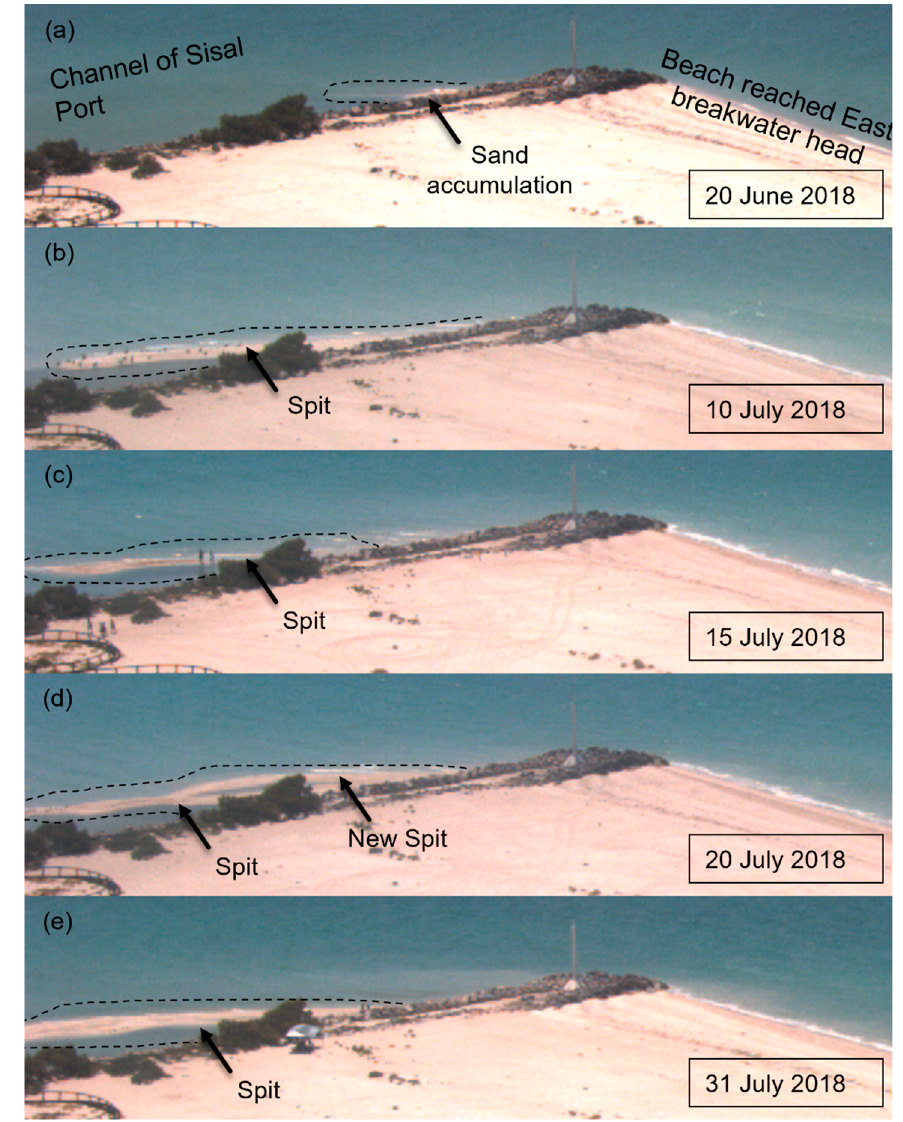
Figure 4. Array of snapshot images from the video monitoring system (location in Figure 1c) from June and July, when the spit was first recorded ( a ), maximum length reached before overwash event ( b ), during overwash event ( c ), after overwash ( d ), and merging after overwash ( e ). Spit is shown inside the black dashed line.